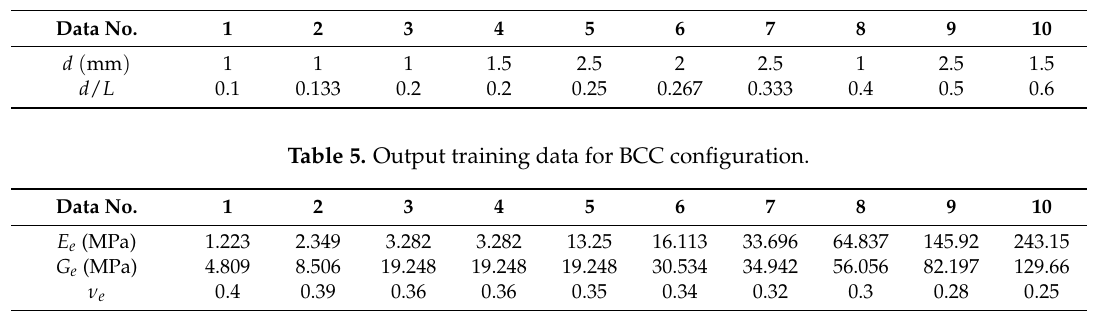
Table 4. Input training data with E = 861 MPa, and ν = 0.35.